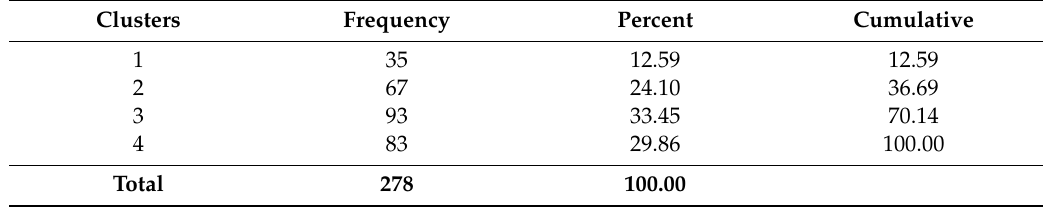
Figure 3. Dendrogram obtained with Ward´s linkage clustering. Table 2. Summary statistics for the clusters obtained.